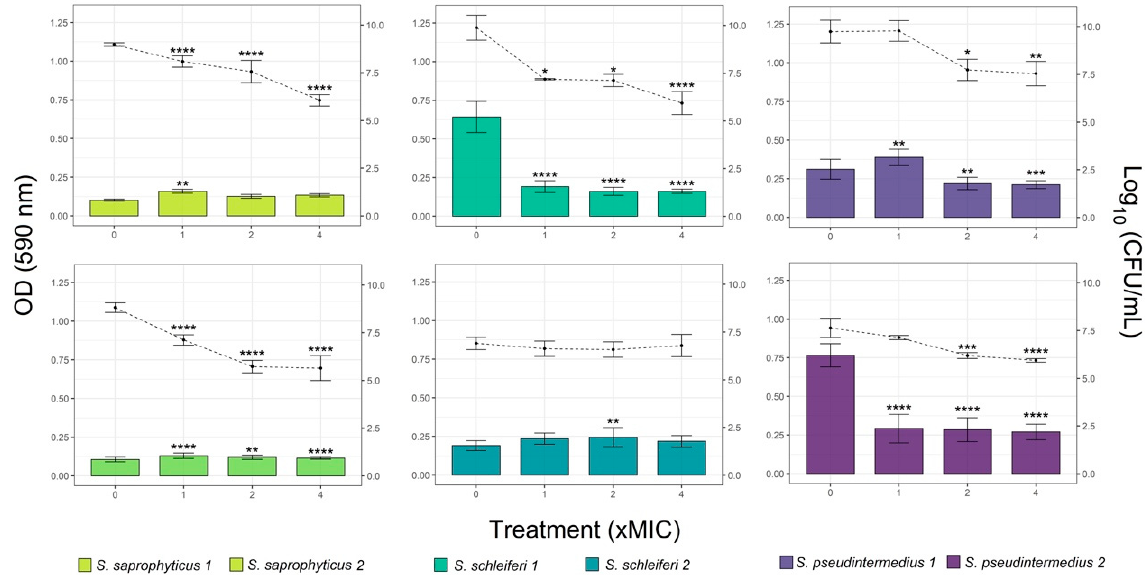
Figure 3. Activity of different concentrations (1-, 2- and 4-fold of MIC) of Cinnamomum zeylanicum essential oil (CZEO) against Staphylococcus preformed biofilm after 4 h of treatment. Biomass quantification by crystal violet staining (OD 590 nm, bars) and colony counting (log 10 CFU/mL, lines). Statistically different by one-way ANOVA with Tukey post hoc test (* p < 0.05; ** p < 0.01; *** p < 0.001; **** p < 0.0001) compared to untreated cells.